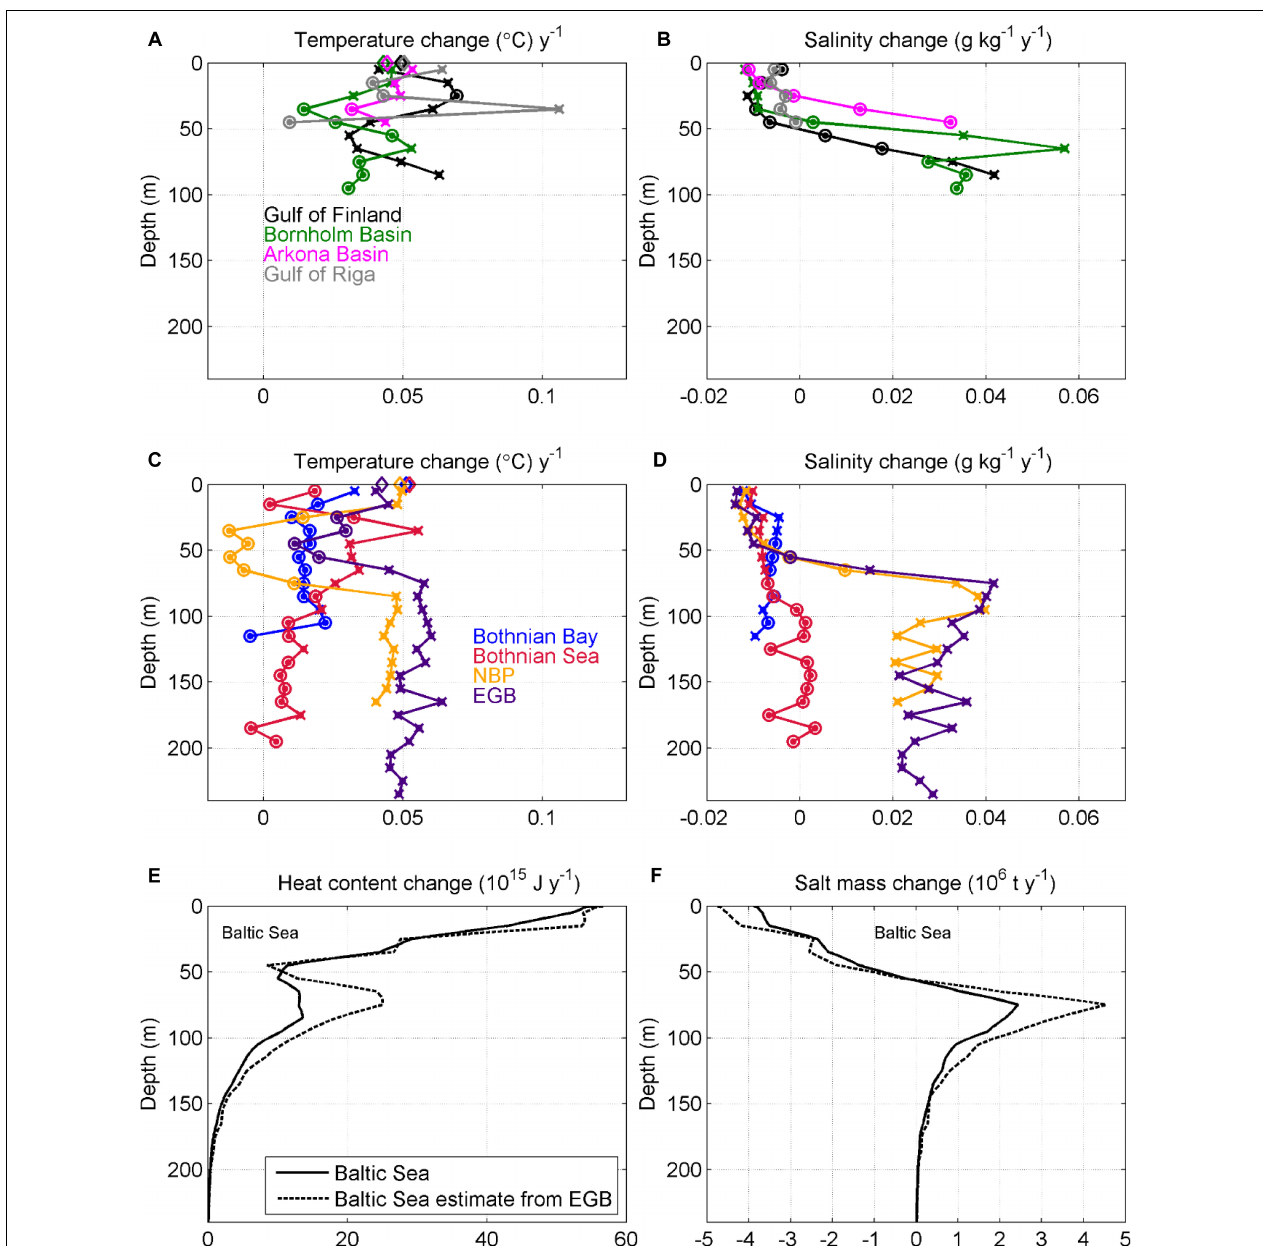
FIGURE 4 | Temperature (A,C) , salinity (B,D) trends in the sub-basins (Gulf of Finland, Bothnian Bay, Bothnian Sea, NBP – Northern Baltic Proper, EGB – Eastern Gotland Basin, Bornholm Basin, Arkona Basin, Gulf of Riga) and heat content (E) , salt mass (F) trends of the whole Baltic Sea from 1982 to 2016. Crosses in the upper panel indicate a statistically significant trend ( p ≤ 0.05) and circles not significant trend ( p > 0.05). Diamonds in the upper part of (A,C) show satellite-based estimates of SST trend in the same areas. Solid lines in the lower panels show the heat content and salt mass estimates if temperature and salinity changes in all eight areas are taken into account. Dashed lines show the estimates if only changes in the Eastern Gotland Basin (EGB) area are taken into account and extrapolated over the entire Baltic Sea using the hypsographic